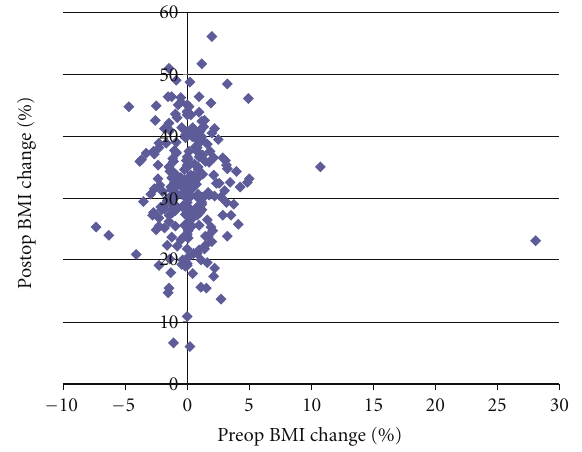
Figure 1: Change in postoperative percent BMI change ( y -axis) as a function of preoperative percent BMI change ( x -axis). There is no significant